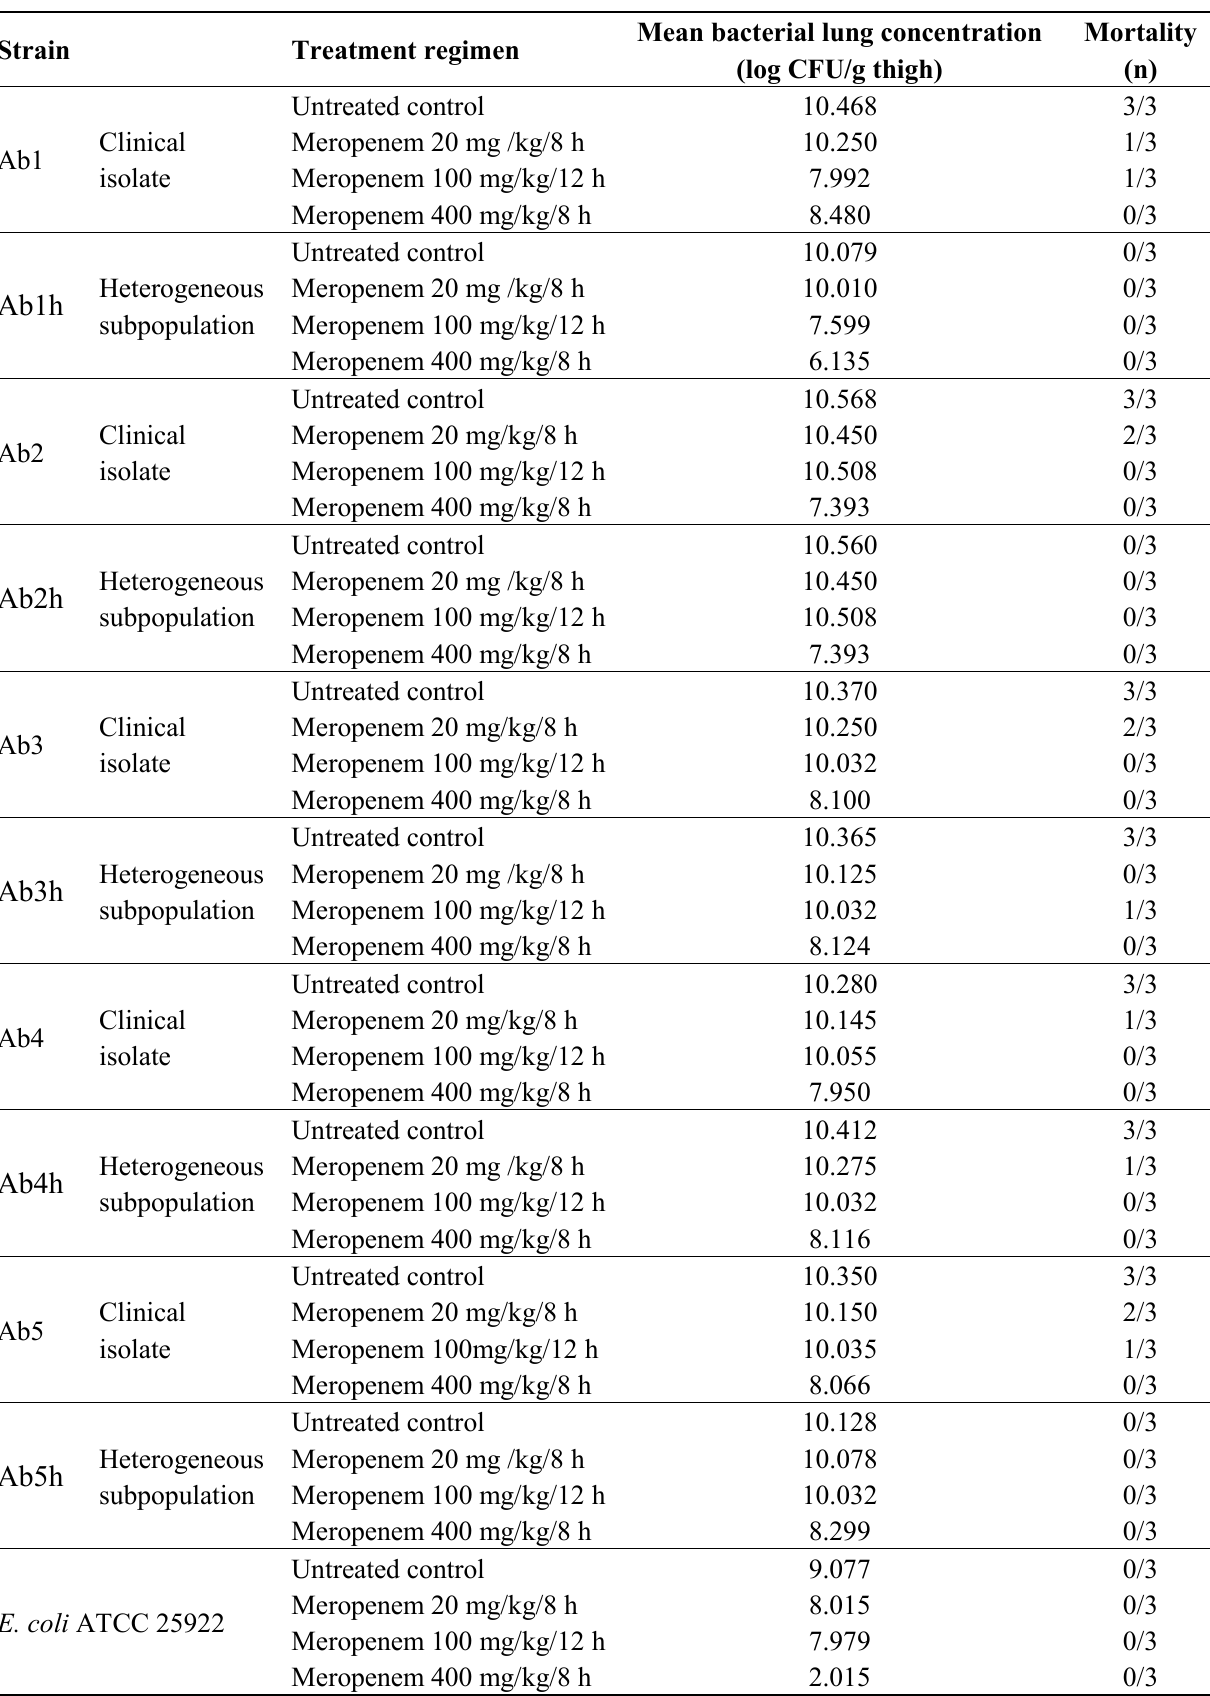
Table 2. Results of the experimental